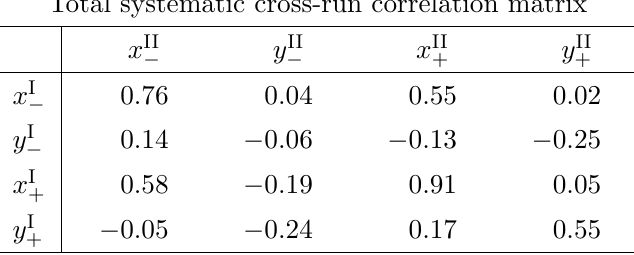
Table 6 . Total correlation matrix for the systematic uncertainties of the Run 1 results (I) and the results presented in this paper (II), including experimental and strong phase related systematic